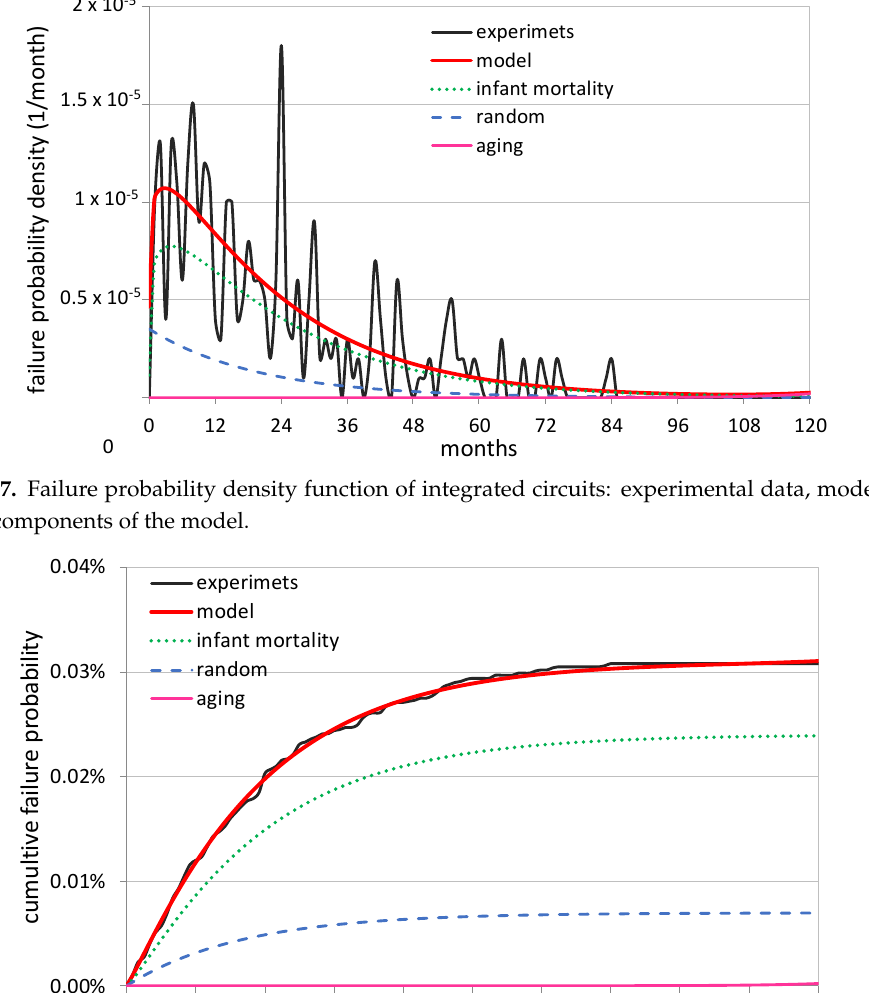
Figure 6. Cumulative failure probability of microcontrollers: experimental data, model and single components of the model.